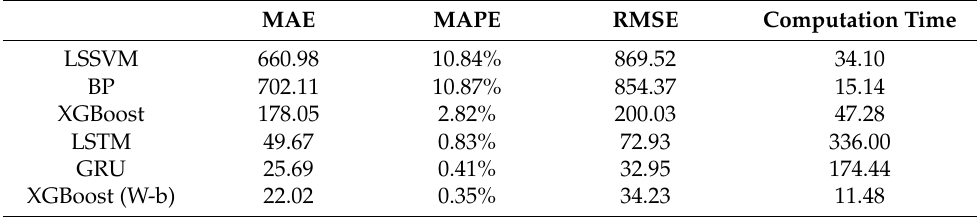
Table 6. The experimental error of each model (considering the real-time electricity